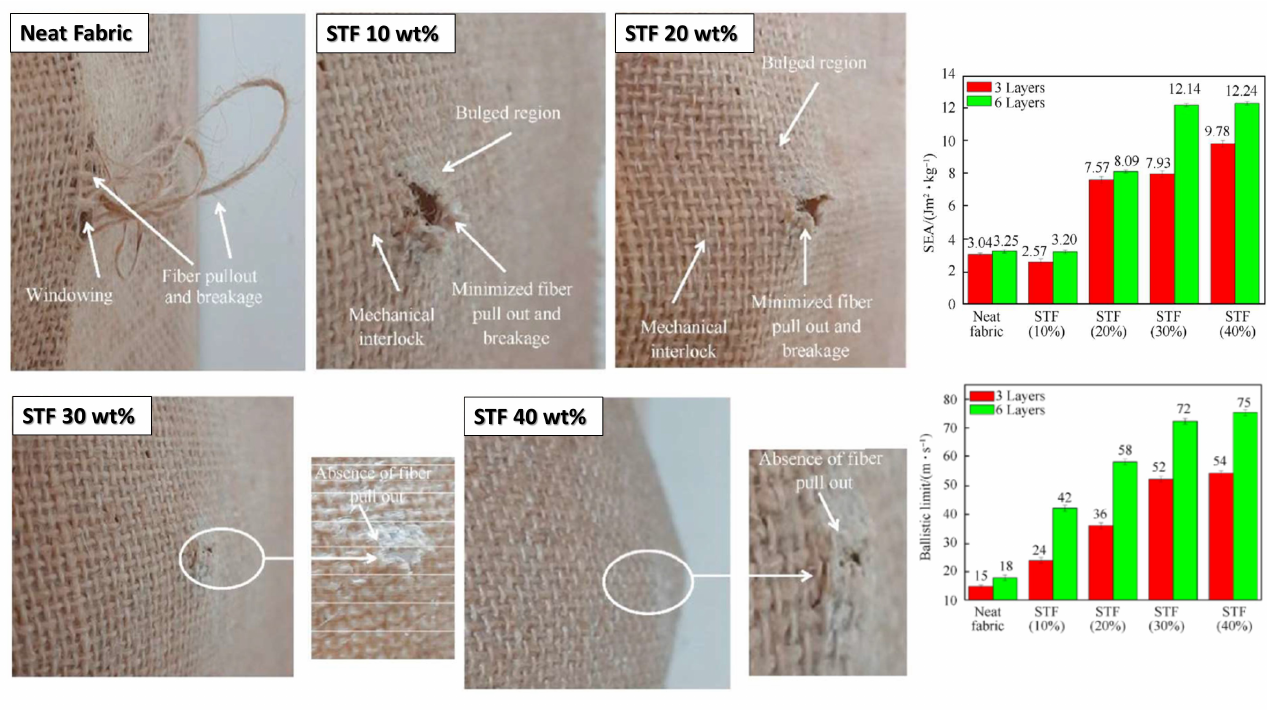
Figure 13. Damaged morphologies of neat jute fabric and jute fabric impregnated with different concentrations of STF. Plots of specific energy absorption (SEA) and ballistic limit of neat jute fabric and impregnated fabrics. Reprinted with permission from Ref. [180]. Copyright 2022,